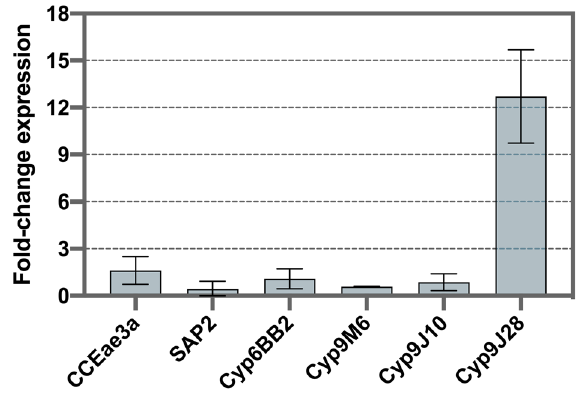
Figure 3. Fold-change expression of genes related to metabolic resistance of insecticides in Aedes aegypti from Lahore. The gene Rps14 was used as a normalizing reference gene, and fold-change was relative to the Rockefeller strain. Means with standard deviations are